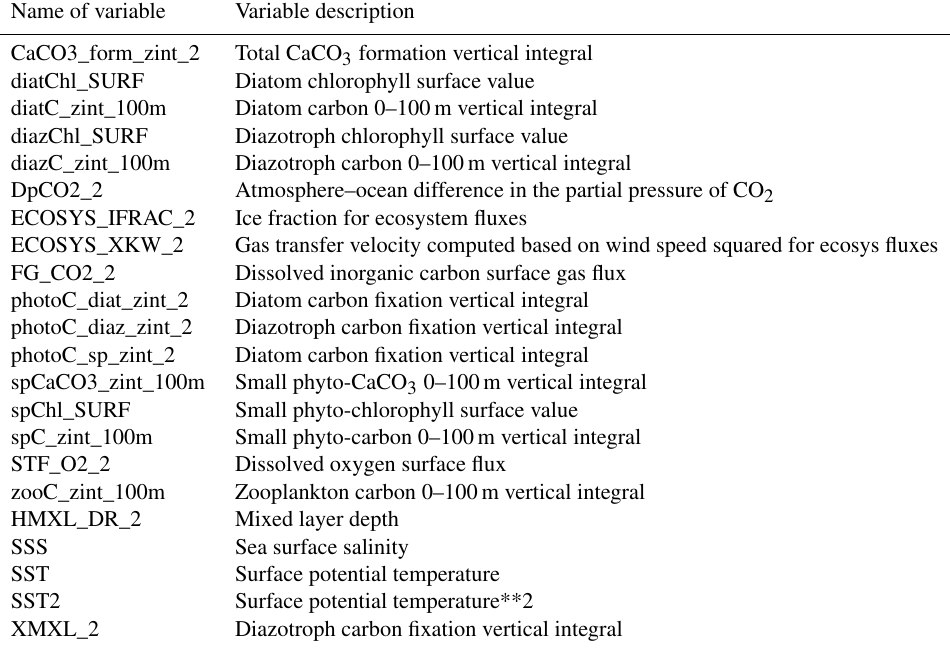
Table A9. Daily averaged output from the ocean model in ARISE-SAI-1.5 simulations and all SSP2–4.5 CESM2(WACCM6)